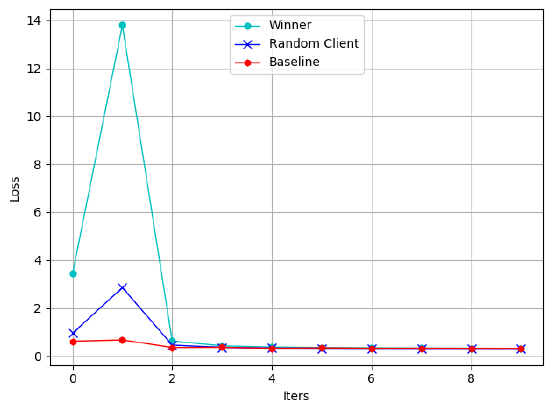
Figure 10. Loss for different participants.